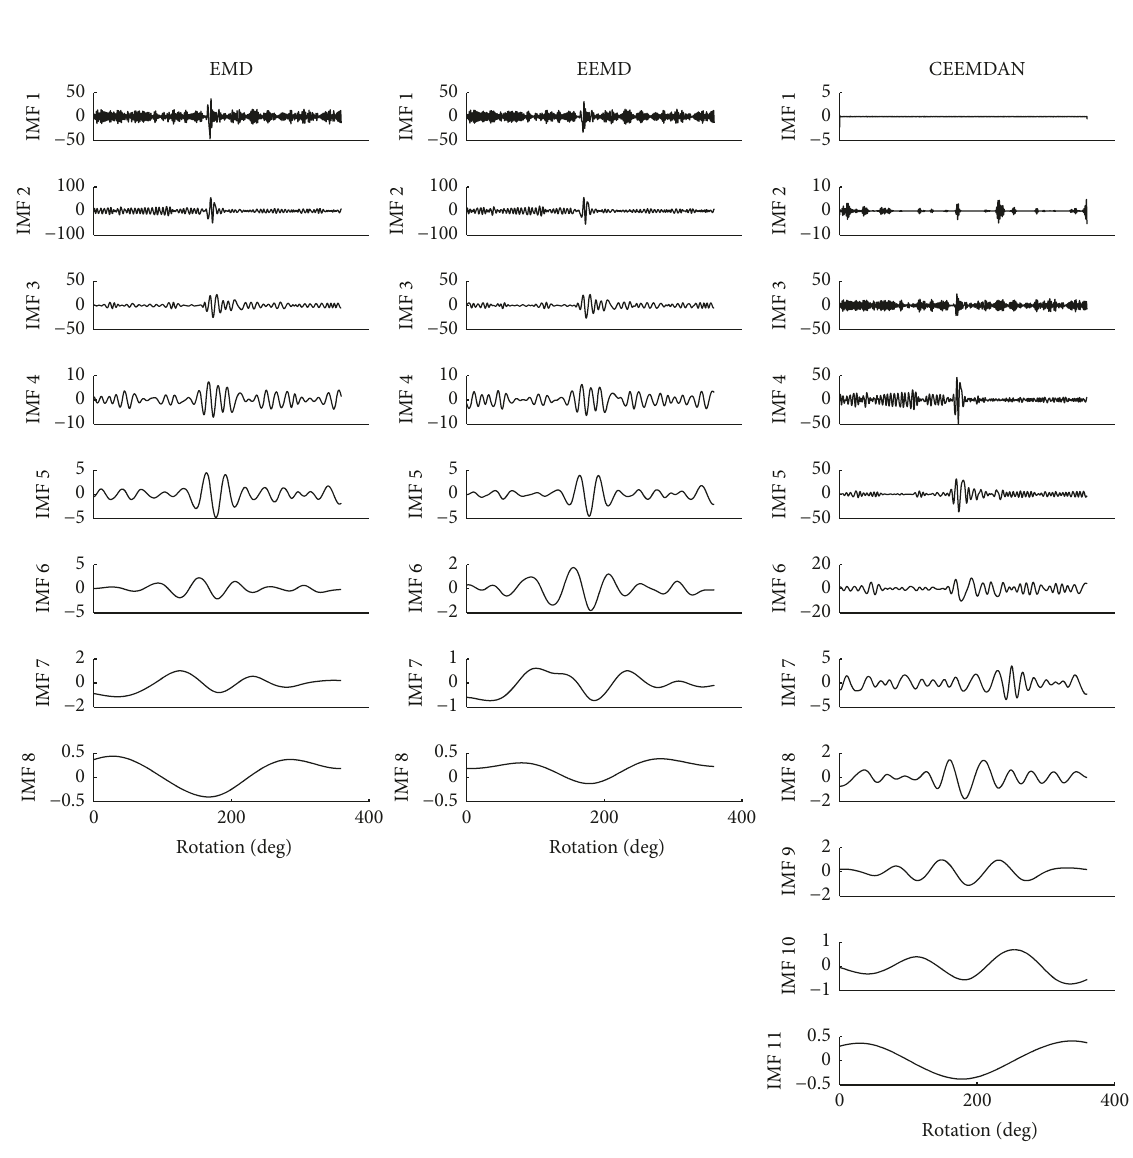
Figure 14: IMF sets of Case 1 obtained by using EMD, EEMD, and CEEMDAN.